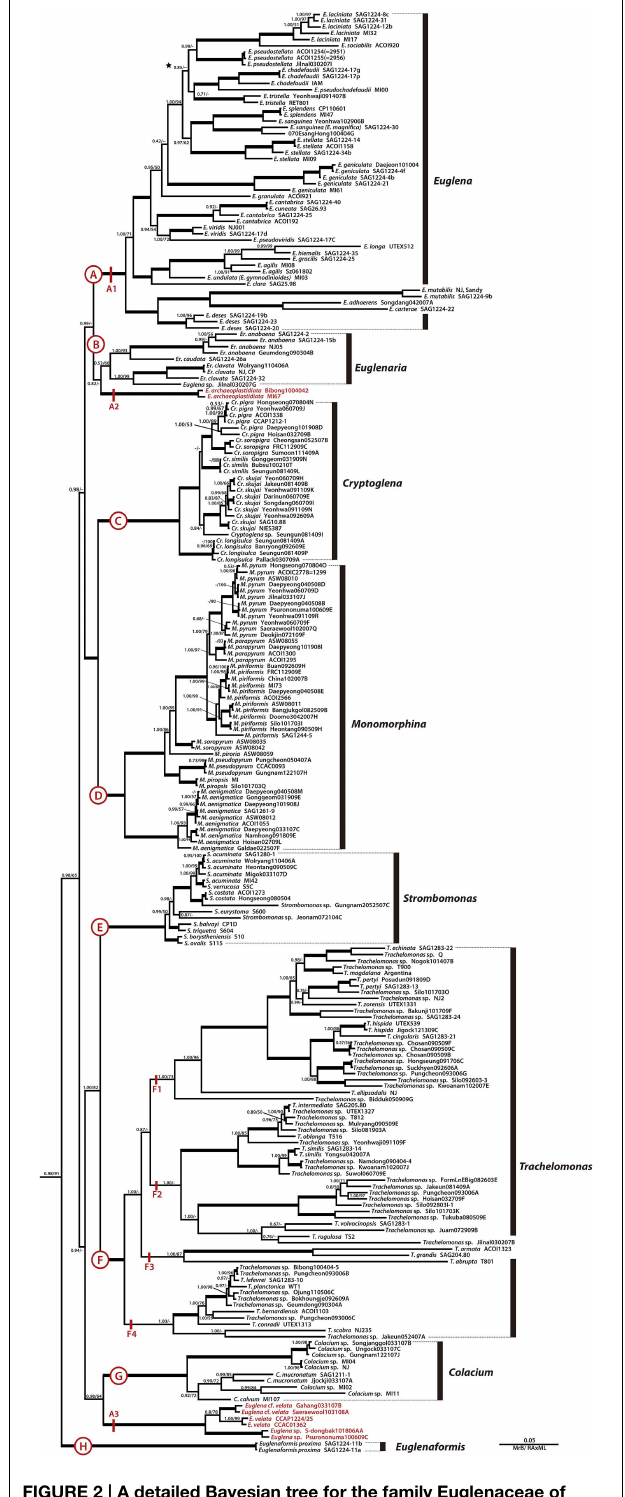
FIGURE 2 | A detailed Bayesian tree for the family Euglenaceae of Figure 1. Clade A is further divided into three lineages (A1–A3). The numbers on each node represents posterior probabilities (left) and bootstrapping values (right) . The bold branches indicate strongly supported values (pp = 1.00 and ML =